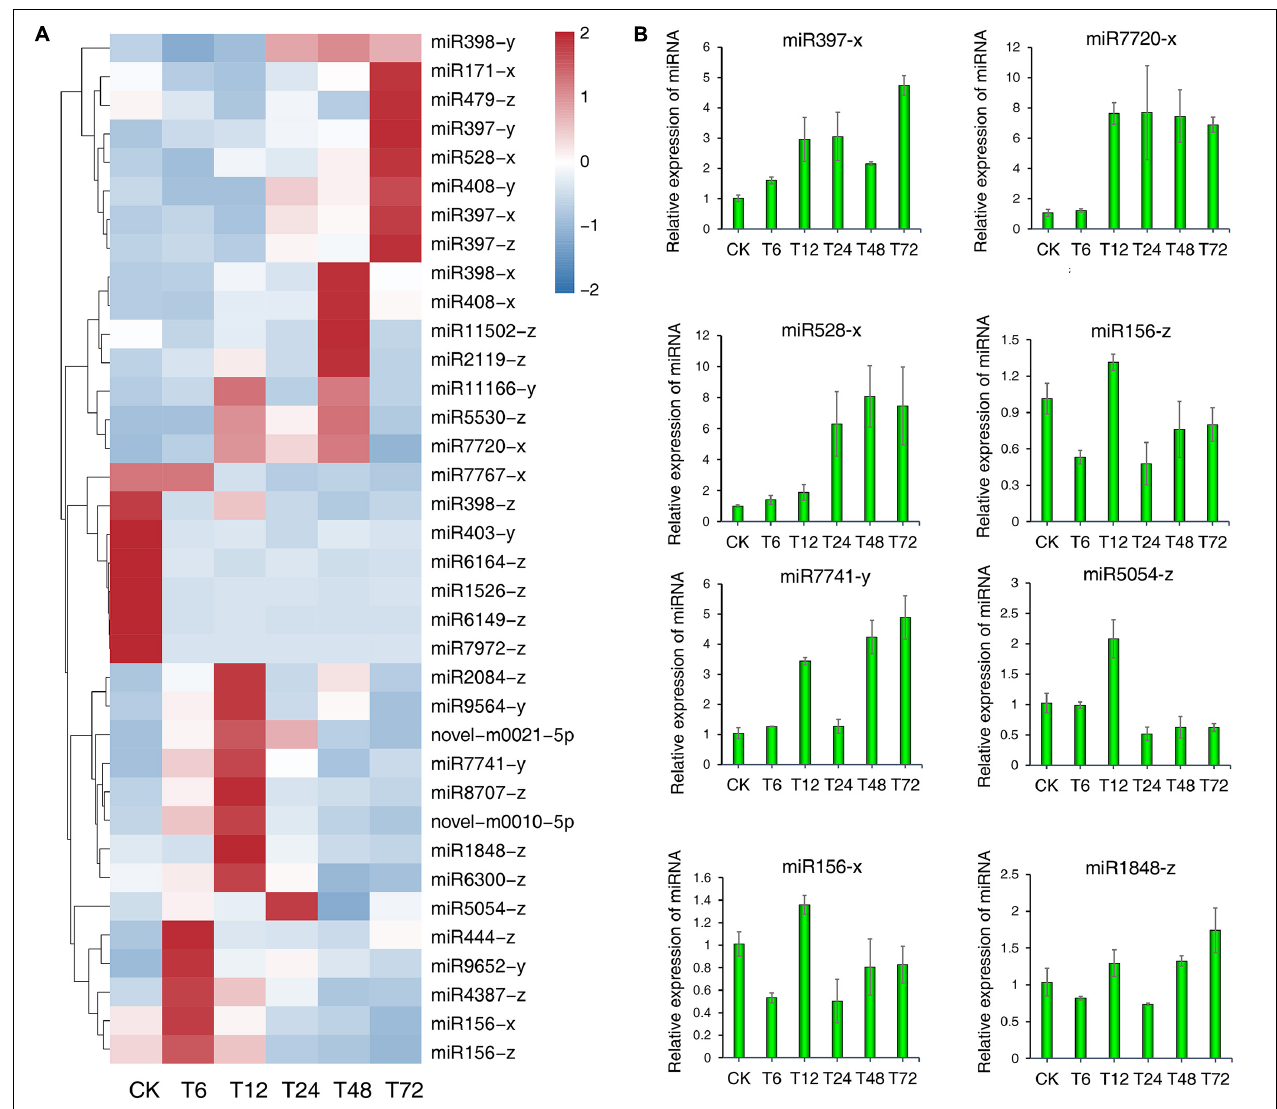
FIGURE 7 | Validation of 8 differentially expressed miRNAs (DEMs) in sugarcane roots under low-K + treatment by stem-loop RT-qPCR. (A) Heatmap of the relative expression levels of all 36 DEMs. (B) Relative expression levels of 8 DEMs detected by stem-loop